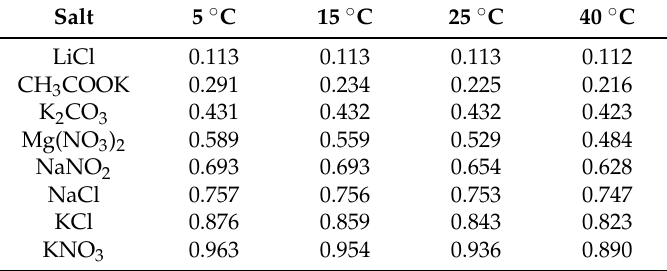
Table 1. The water activities ( a w ) of saturated salt solutions at 5, 15, 25 and 40 ˝